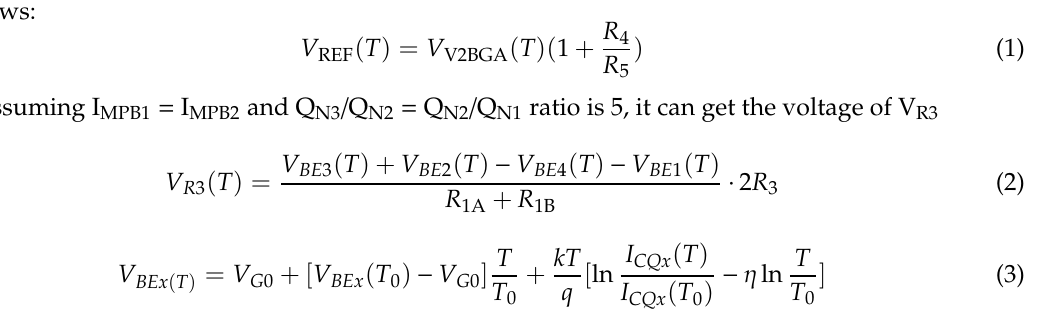
Figure 3. Concept of proposed stacked piece-wise compensated bandgap reference (SPWBGR).